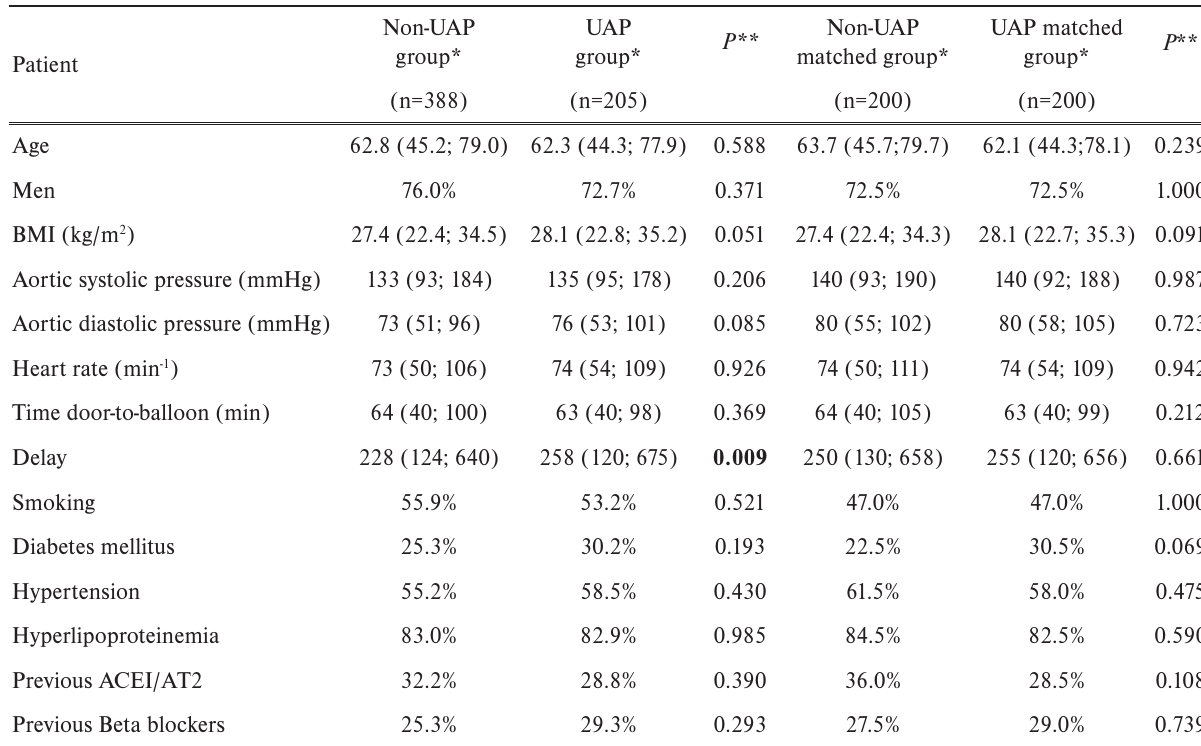
Table 1. Baseline characteristics according to the presence of prodromal unstable angina pectoris in all patients and in matched groups using propensity